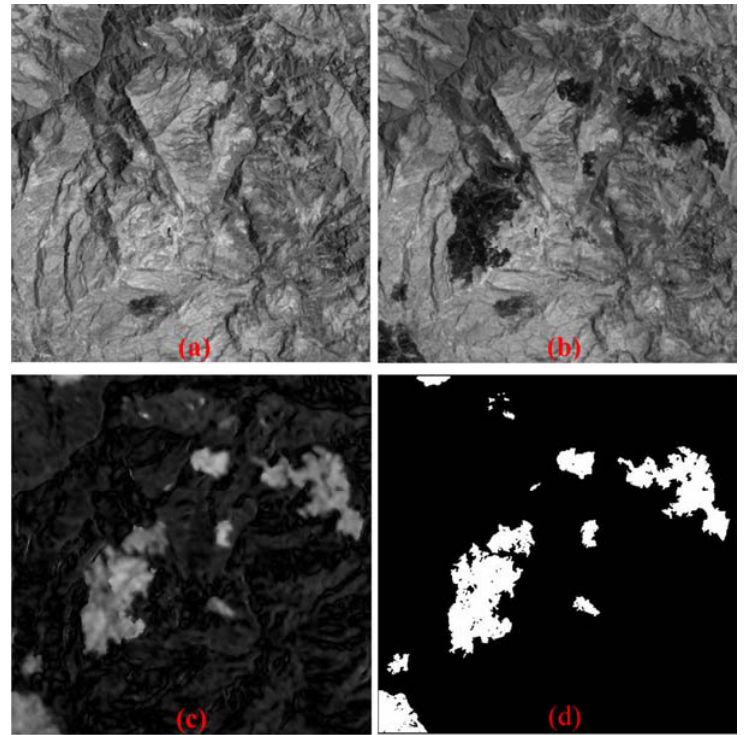
Figure 4. Images of Mexico Area: ( a ) band 4 of the Landsat ETM+ captured in April 2000, ( b ) band 4 of the Landsat ETM+ captured in May 2002, ( c ) corresponding CMI obtained by the proposed approach, and ( d ) reference map of the changed area.